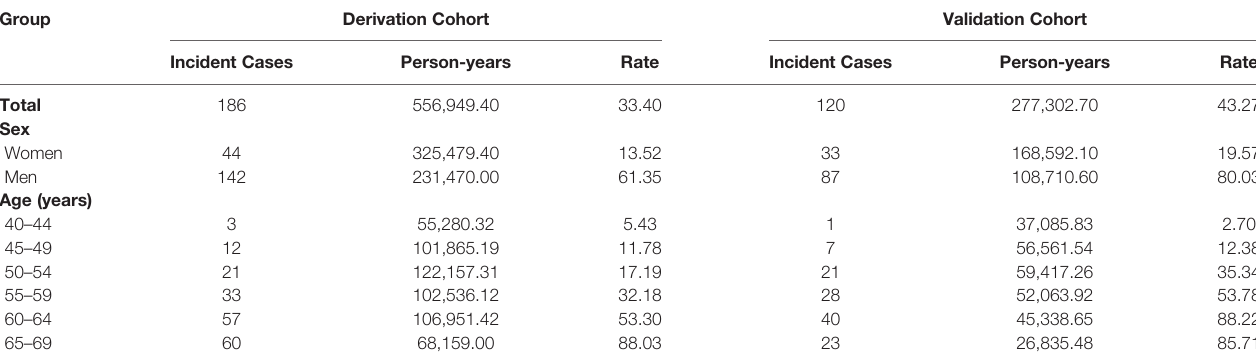
TABLE 2 | Incidence rates of ESCC per 100,000 person-years in the derivation cohort and validation cohort.